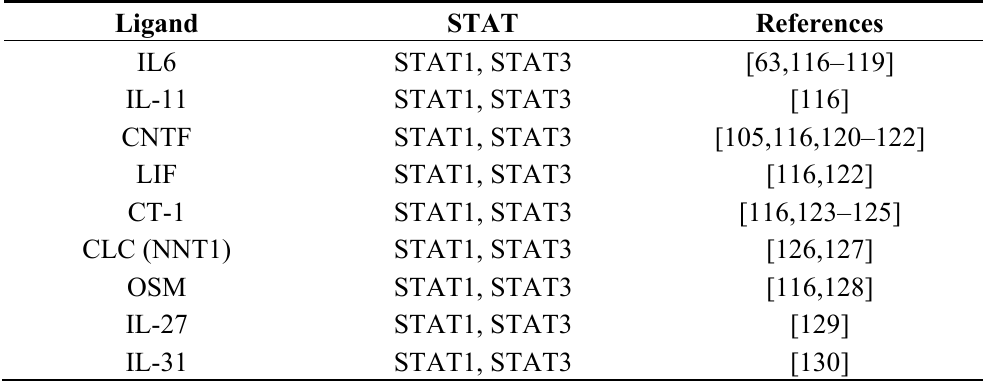
Table 1. IL-6 Family cytokine demonstrated to act through the JAK-STAT pathway. Ligand